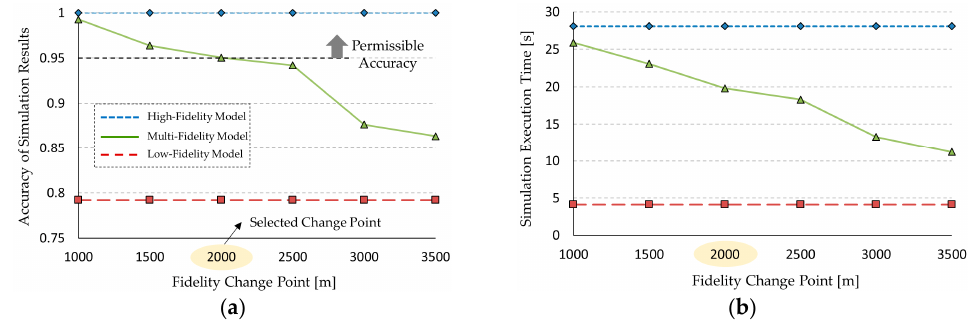
Figure 18. Simulation results to decide the fidelity change point of “ Distance ”: ( a ) Simulation accuracy against the change point; ( b ) simulation execution time against the change point.